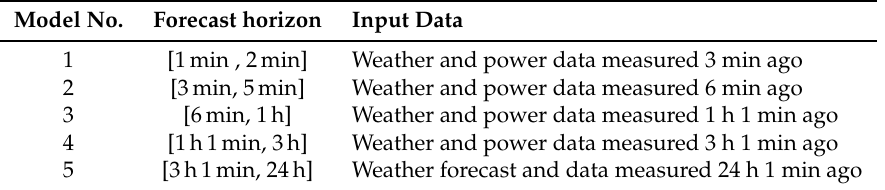
Table 4. To take measured weather data into account when modeling the photovoltaic plant, the model based on weather forecast data is substituted by multiple models. Each of these models can calculate forecasts for different parts of a 24-h forecast horizon and uses different input data.